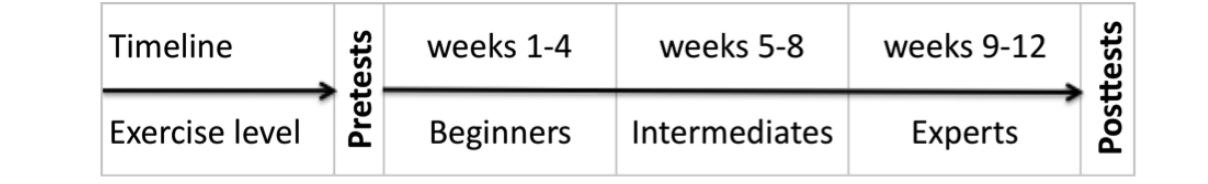
Figure 3. Timeline and exercise